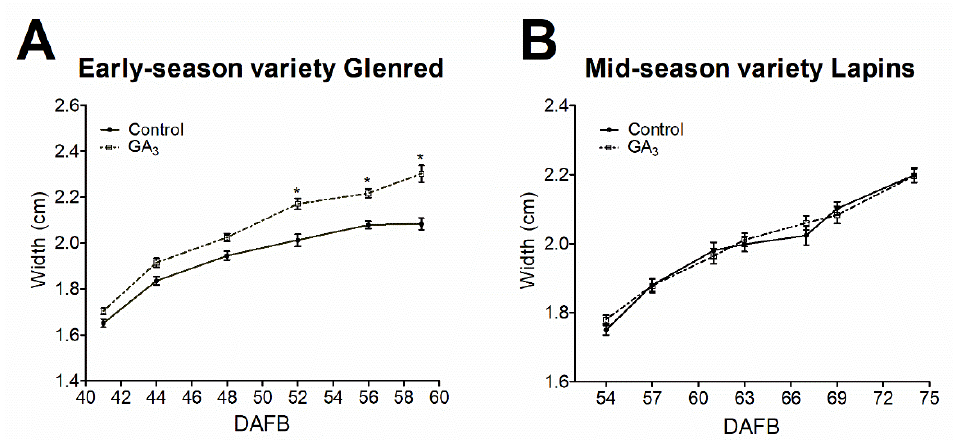
Figure 2. Effect of exogenous gibberellic acid (GA 3 ) on fruit growth of early-season variety, Glenred ( A ) and mid-season variety, Lapins ( B ) 20 fruits from control and GA 3 trees of Lapins and Glenred were randomly selected for measurements. Data as ± SEM ANOVA with Tukey’s post hoc test at p < 0.05 was conducted; “*” denotes statistical differences between GA 3 -treated and control fruits. DAFB, days after full bloom. Table 1. Ripening parameters at harvest of mid- and early-season varieties in the